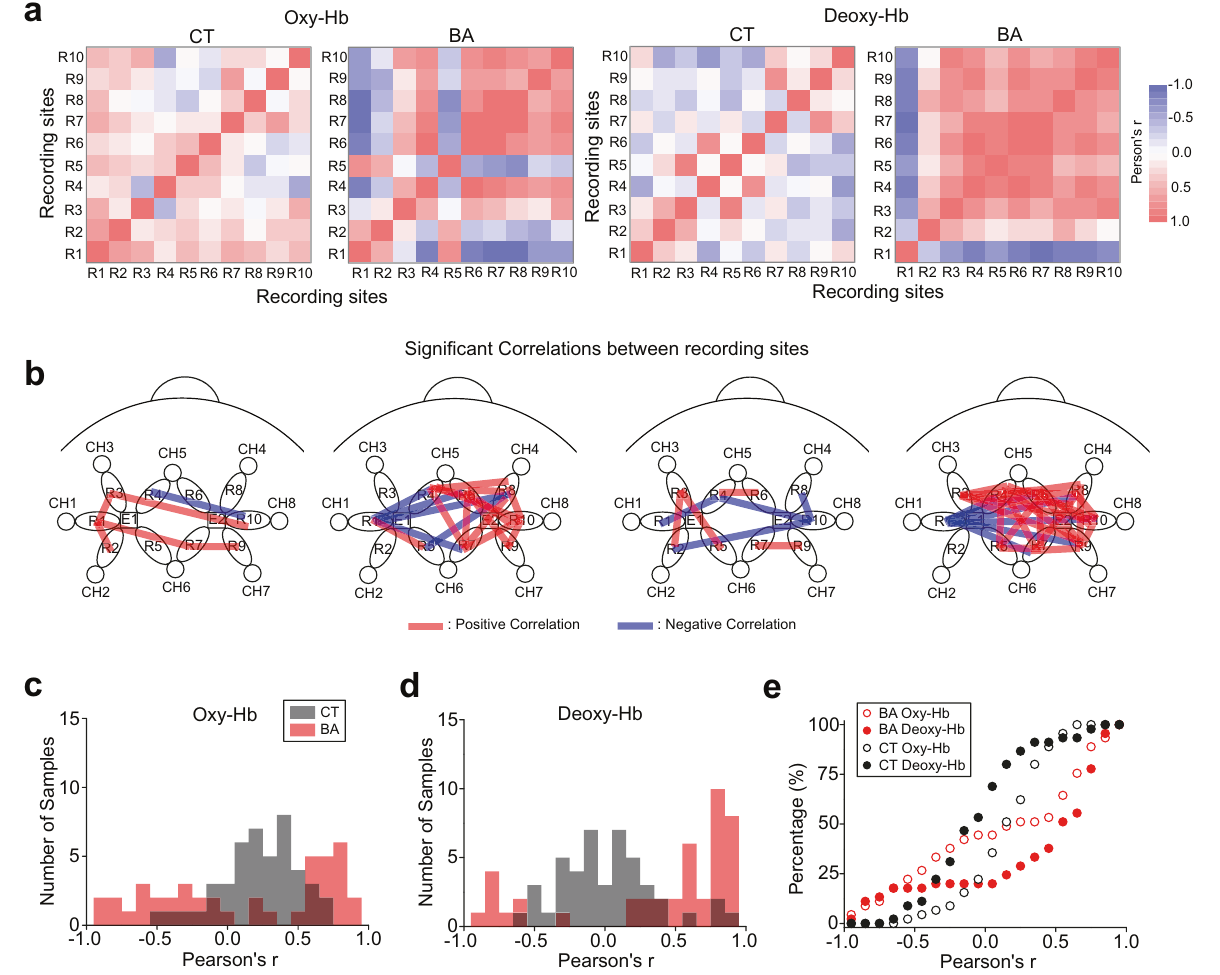
Fig. 3 Correlations of Oxy-Hb and deoxy-Hb changes within the PFC network associated with the PASP test. a Heat maps illustrating correlations (Pearson ’ s r ) of oxy-Hb and deoxy-Hb changes in every possible pair of recording sites. BA behavioural addiction, CT control. b Schematic diagrams illustrating correlations in pairs of recording sites that were statistically signi fi cant ( p < 0.05). Positive and negative correlations are illustrated with red and blue lines, respectively. c – e Histograms illustrating distributions of Pearson ’ s r for oxy-Hb ( c ) and deoxy-Hb ( d ) and a cumulative histogram ( e ) in BA patients and CT subjects.